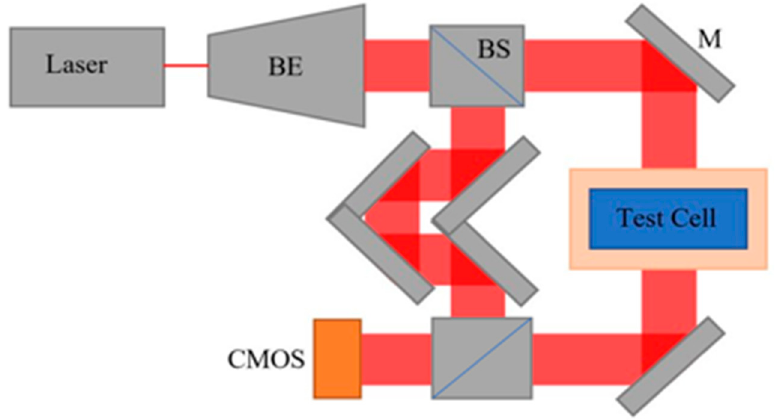
Figure 2. Schematic diagram of the DHI-based OC dosimeter. BE, BS, M, and CMOS denote beam expander, beam splitter, mirror, and CMOS detector, respectively. Not shown is the FLASH proton beam that irradiates the test cell.